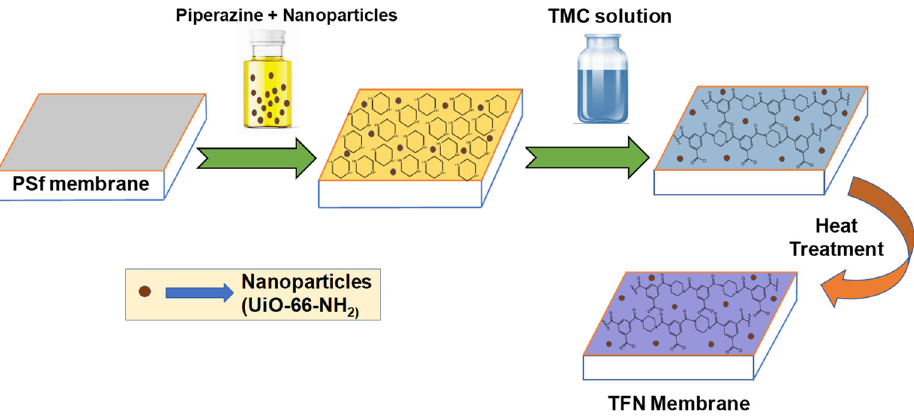
Figure 1. Representation of preparation of TFN (thin-film nanocomposite) layer on the surface of PSf membrane (Polysulfone-membrane) via interfacial polymerization method.